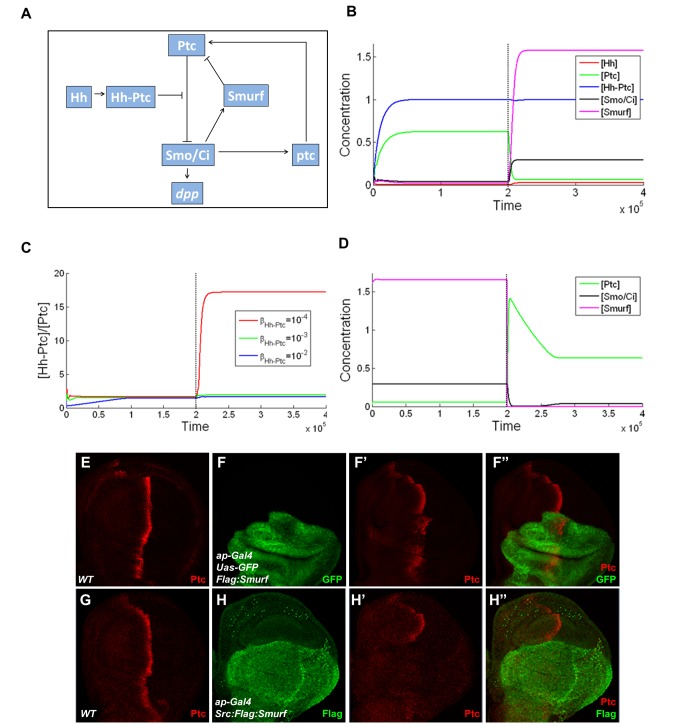
Bidirectional regulation and role of activated Smurf in the Hh signaling pathway.(A) A simplified Hh signaling pathway network for mathematic modeling. (B) The effects of over expression of activated Smurf on [Hh], [Ptc], [Hh_Ptc], [activated Smo/Ci]. On the left, the levels of [Hh], [Ptc], [Hh_Ptc], and [activated Smo/Ci] correspond to the low level of [activated Smurf], and, similarly, on the right, the levels of [Hh], [Ptc], [Hh_Ptc], and [activated Smo/Ci] correspond to the high level of [activated Smurf] (i.e., over expression of activated Smurf). (For the value of each parameter, see Table S1.) (C) The effect of over expression of activated Smurf on the ratio [Hh_Ptc]/[Ptc]. For all three values of βHh_Ptc, the level of ratio [Hh_Ptc]/[Ptc] corresponding to the low activated Smurf is low (on the left). However, when the activated Smurf is over expressed, the level of ratio [Hh_Ptc]/[Ptc] corresponding to βHh_Ptc = 10−4 is significantly high. (For the value of each parameter, see Table S1.) (D) The effects of the inhibition of activated Smurf on [Ptc] and [activated Smo/Ci]. When the expression of activated Smurf is inhibited, the levels of [Ptc] and [activated Smo/Ci] decrease immediately (on the right). (For the value of each parameter, see Table S1.) (E and F–F″) Wild-type control discs were immunostained with anti-Ptc antibody to show Ptc protein expression (E), and wing discs expressing Flag:Smurf driven by ap-gal4 were immunostained to show the expression of Ptc (red) and GFP(green), which shows the area of Smurf expression (F–F″). (G and H–H″) Wild-type control discs were immunostained with anti-Ptc antibody to show Ptc protein expression (G), and wing discs expressing Src:Flag:Smurf driven by ap-gal4 were immunostained to show the expression of Ptc (red) and Flag (green) (H–H″).